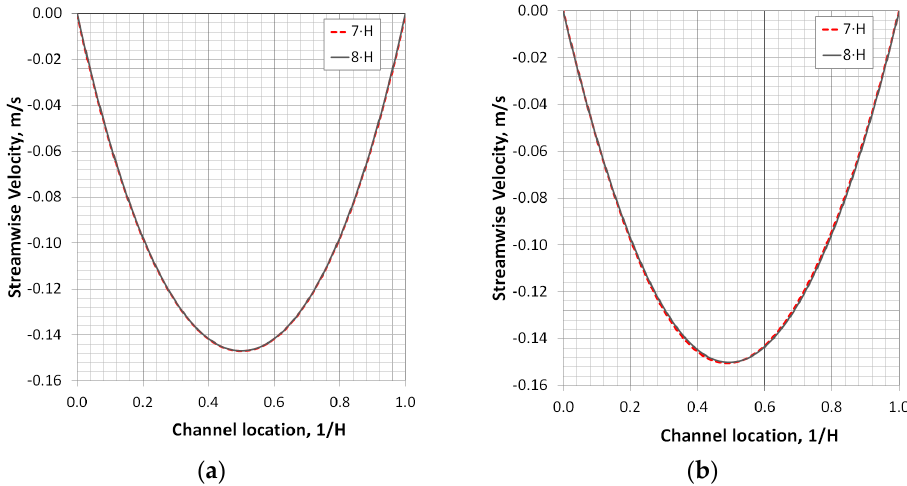
Figure A2. Streamwise velocity downstream of the corner bend: ( a ) elastic vortex for Wi = 1.0, El = 100, β = 0.1; ( b ) inertial vortex for Re = 100.